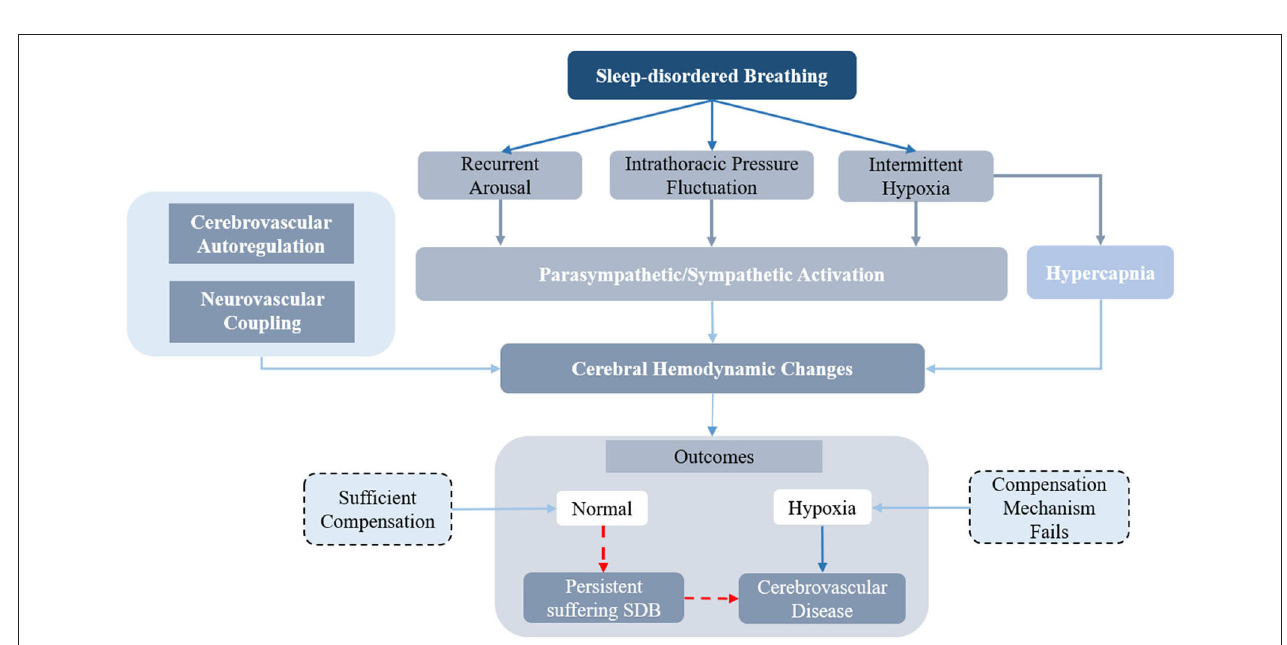
FIGURE 6 | The diagram of the cerebral hemodynamics regulation in sleep disordered breathing.